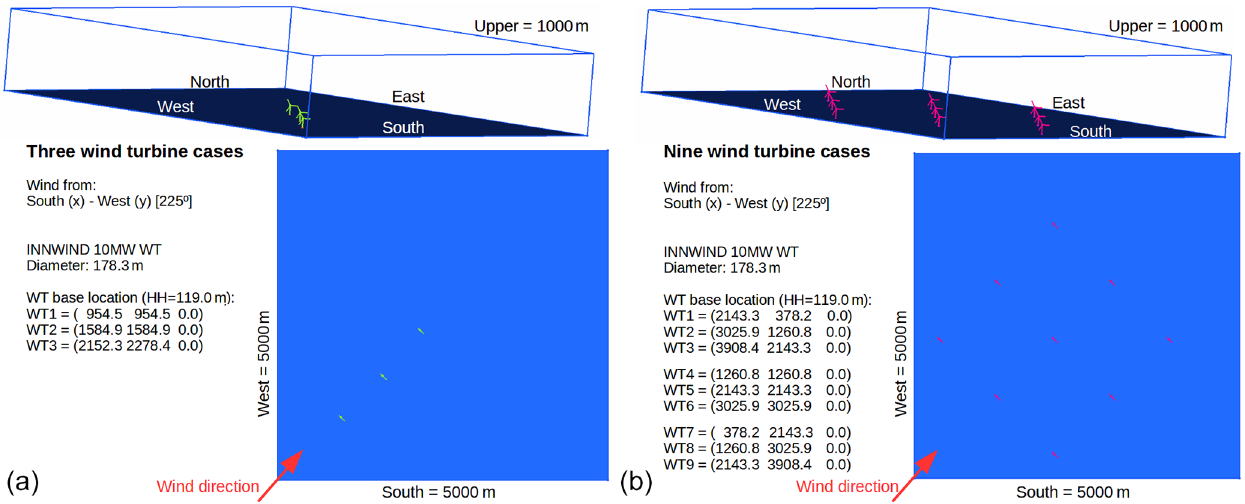
Figure 15. CL-Windcon LES layouts: (a) 3WT scenario and (b) 9WT scenario. Table 7. Yaw misalignment control settings for the calibration and blind test for CL-Windcon LES cases. Yxxx: the downstream turbines are not misaligned where xxx [ ◦ ] indicates the yaw misalignment of the upstream turbine(s) (WT1 for 3WT scenario; WT1, WT4, and WT7 for 9WT scenario). Yxxx_Yyyy: upstream and the first downstream turbines are misaligned, where xxx [ ◦ ] and yyy [ ◦ ] indicate the yaw misalignment of the upstream and downstream turbines respectively. For 9WT scenario, xxx or yyy =− 123 indicates − 10, − 20, and − 30 ◦ yaw setting at turbines WT2, WT5, and WT8